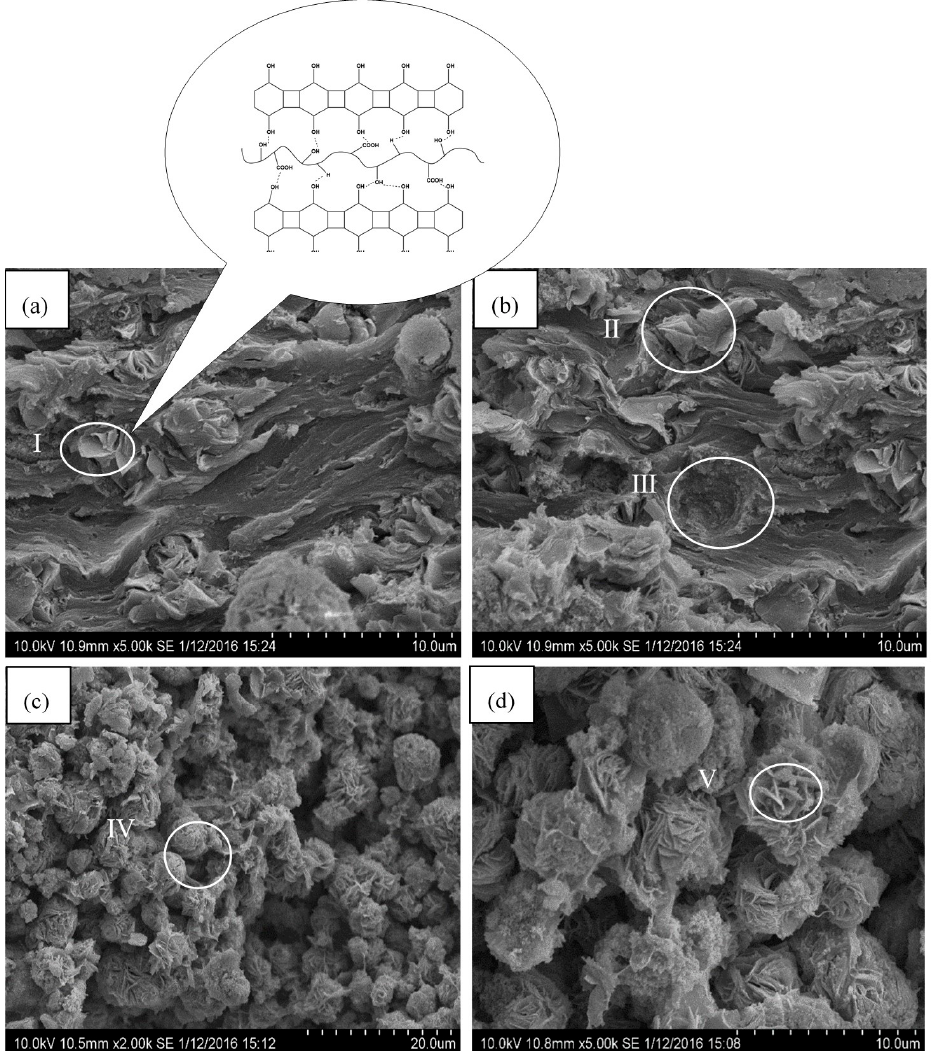
Figure 2. Scanning electron microscope (SEM) image of cutting fracture section of (a) (b) CMC/MAG– 20 (c) (d) CMC/MAG–40. ( c , d ) CMC /